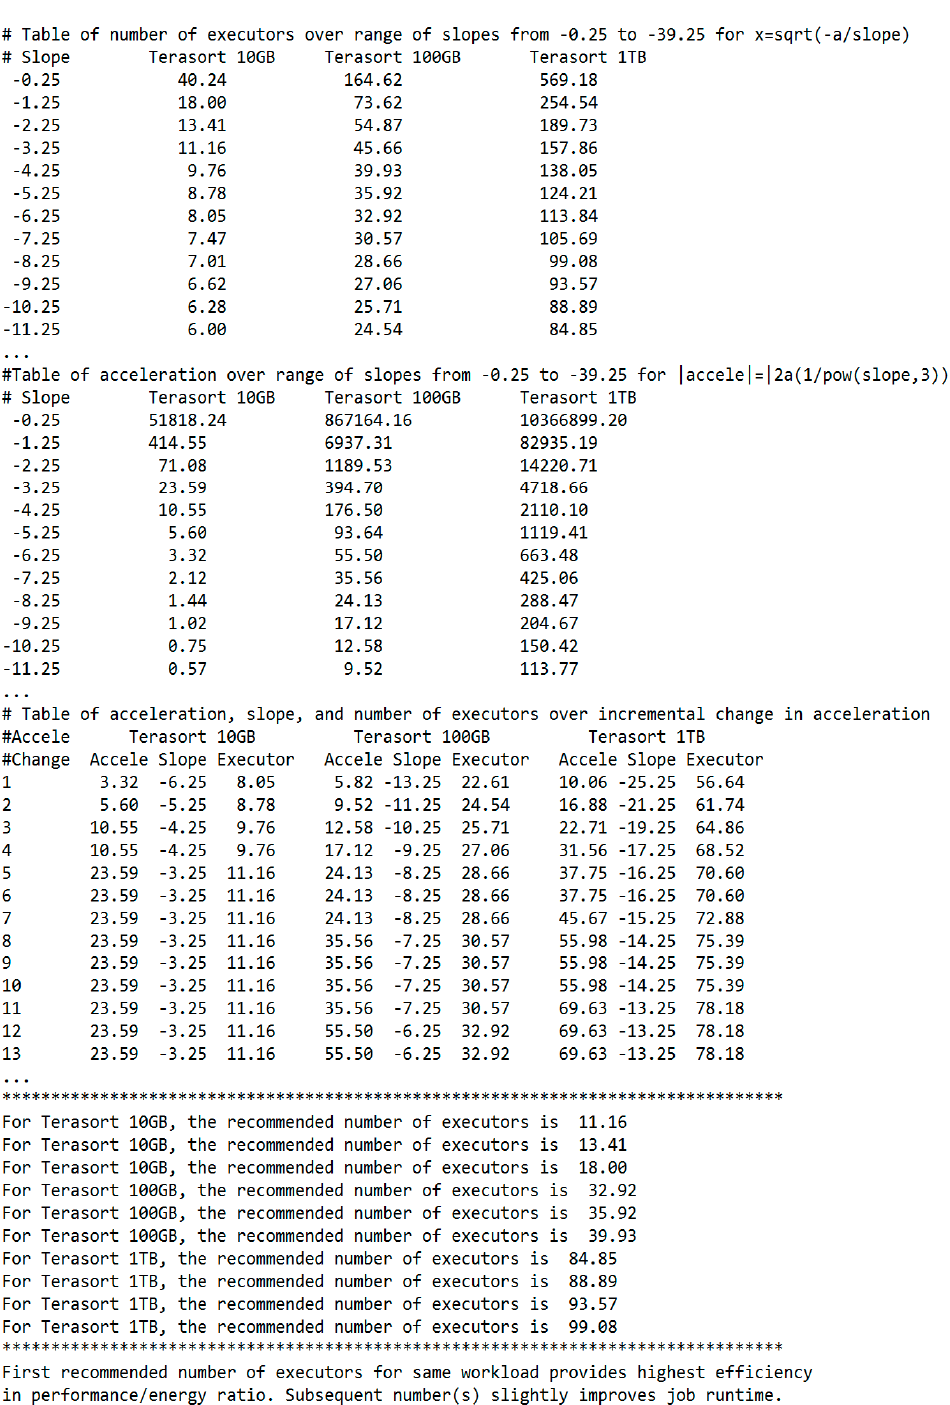
Figure 6. Applying BToP algorithm to Spark-Bench Terasort 10 GB, 100 GB, and 1 TB workloads to tabulate the number of executors over range of slopes, acceleration over range of slopes, and recommended acceleration, slope, and optimal number of executors over range of incremental changes in acceleration per slope increment, to output the final recommended optimal numbers of executors for each workload.